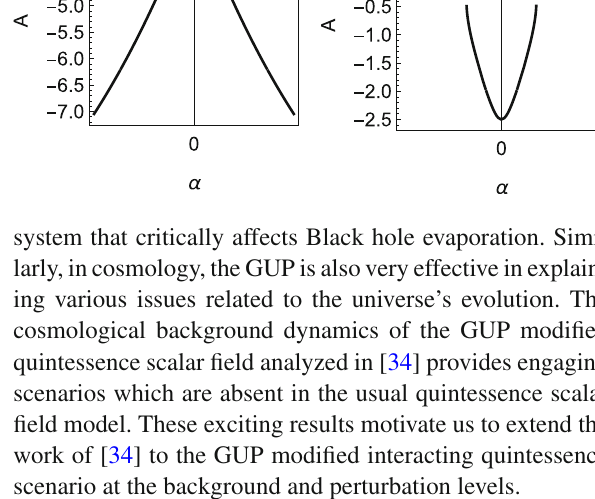
Fig. 8 The dependency of the exponents of the linear system (103), (104) with the coupling parameter α is displayed in the plots